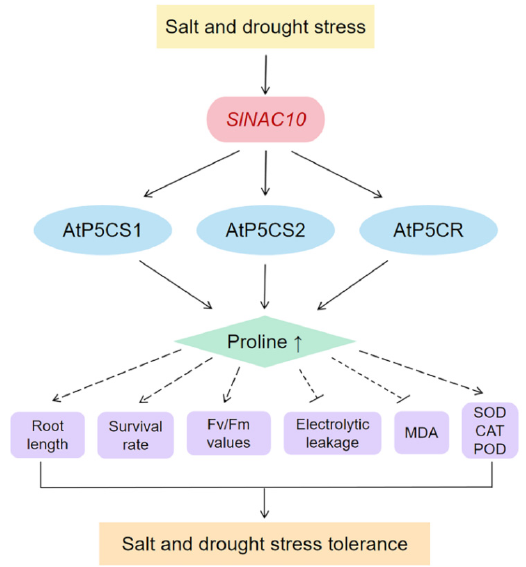
Figure 10. Technology roadmap of this study.